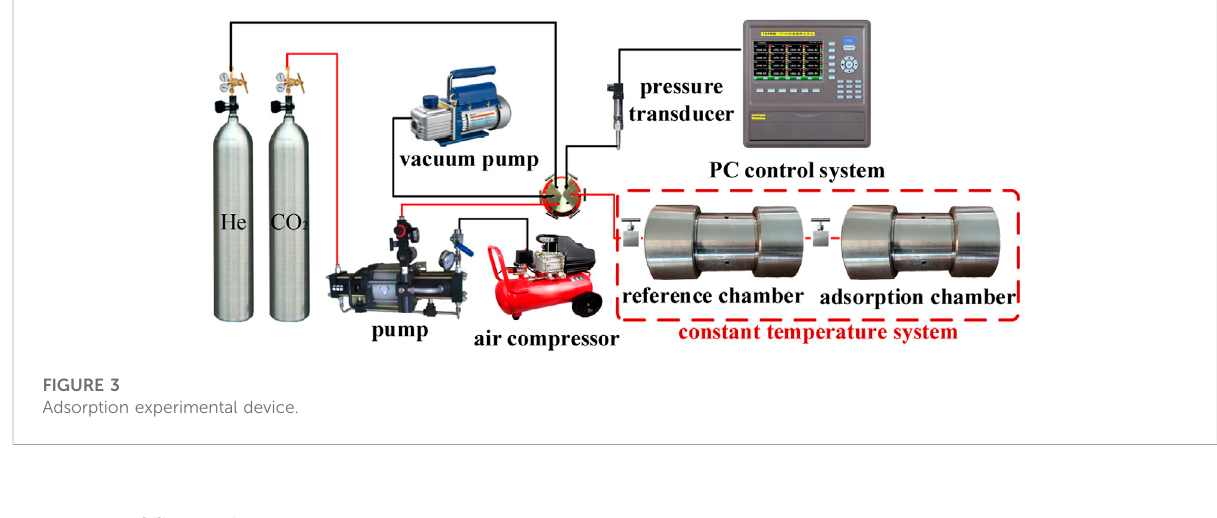
TABLE 2 Permeability experiment program.